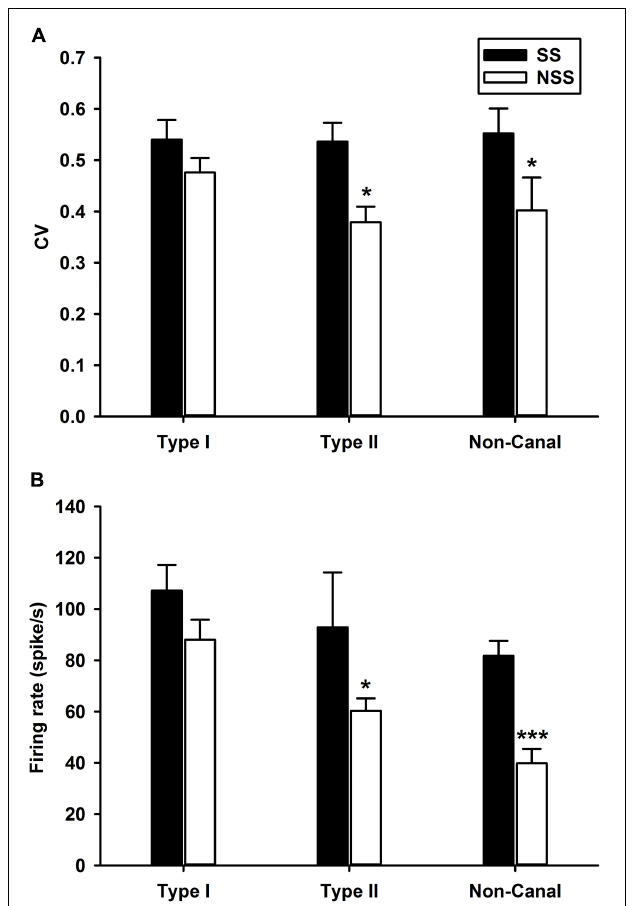
FIGURE 4 | Comparisons of spontaneous firing rates and regularity (CV) between sound sensitive (SS) and non-sound sensitive (NSS) vestibular nucleus neurons. (A) CV. The SS Type II and non-canal neurons were more irregular than NSS neurons. (B) Spontaneous firing rates. The SS Type II and non-canal neurons had higher spontaneous firing rates than NSS neurons. *** P < 0.001, * P < 0.05.